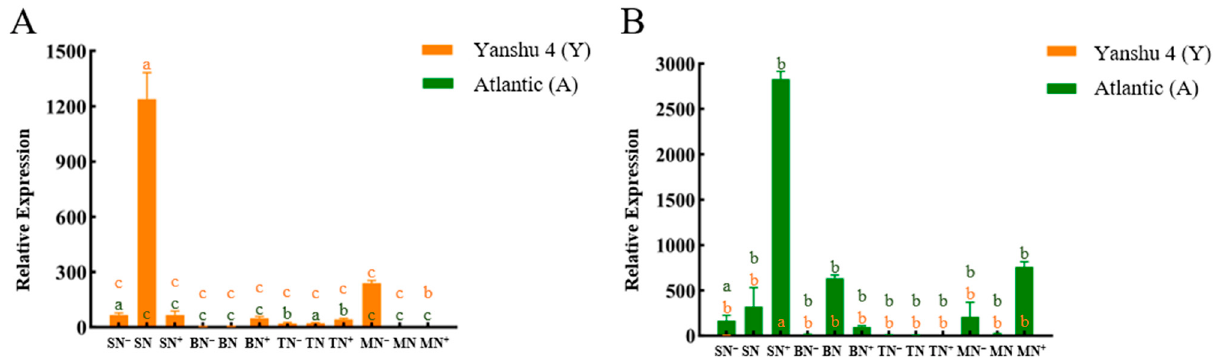
Figure 6. Relative expression of glutamine synthase gene StGS1-4 in two genotypes of potato under different N supply levels. ( A ) Leaf (L); ( B ) Root (R). S, B, T, and M represent seedling stage, budding stage, tuber expansion stage, and mature stage, respectively. N − , N, N + are different N supply levels, representing low N, normal N, and excess N, respectively. Different letters indicate the difference of relative gene expression in different periods under different N application levels ( p < 0.05).